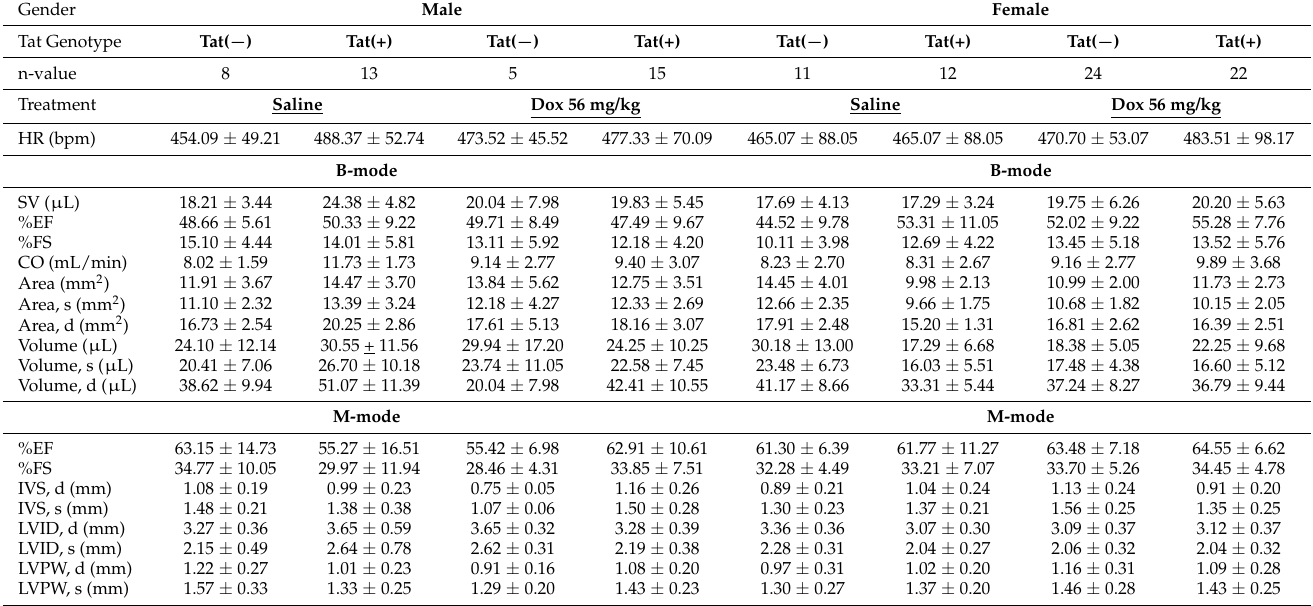
Table 1. Morphological and cardiac functional assessments by echocardiogram parameters including brightness- (B-mode) and motion-mode (M-mode) measurements among HIV-1 Tat transgenic mice treated with saline or